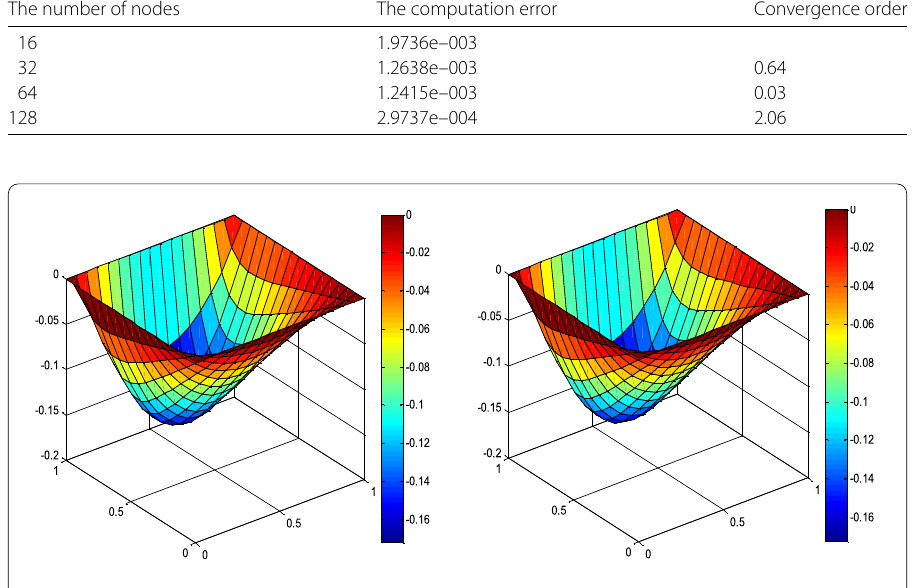
Table 3 The convergence order of the proposed method L1-TFPM as γ = 0.8 The number of nodes The computation error Convergence order